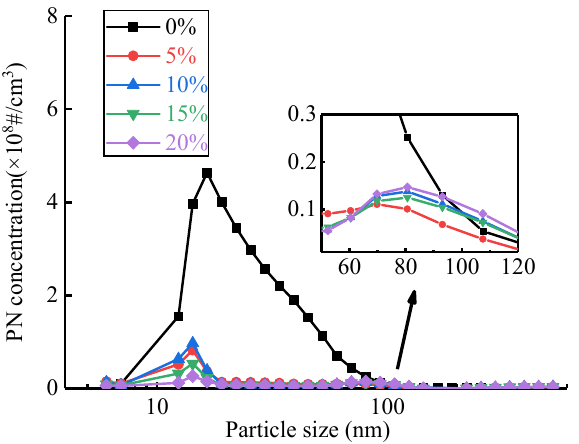
Figure 6. Particle size distribution characteristics under different EGR rates at 4000 r/min full load.